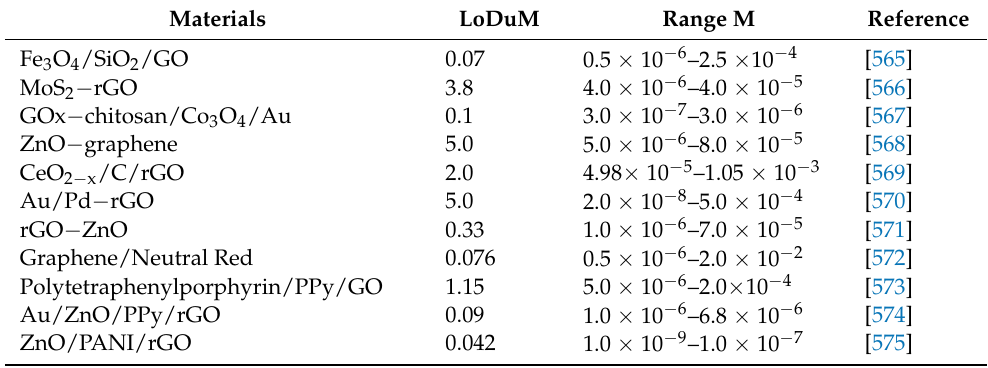
Figure 31. Working mechanism of graphene-based UA biosensor. (Reproduced from [564] under common creative.). Table 6. Graphene-based uric acid